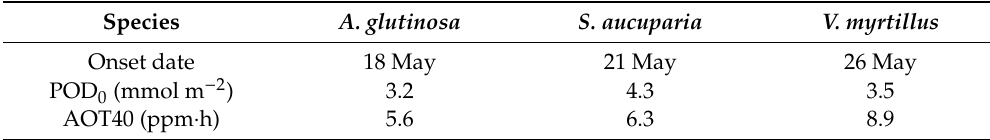
Table 1. The date of first symptom onset of O 3 visible foliar injury and corresponding ozone indices exposure over a threshold of 40 ppb) for Alnus glutinosa , Sorbus aucuparia, and Vaccinium myrtillus in 2.0 × AA (twice ambient O 3